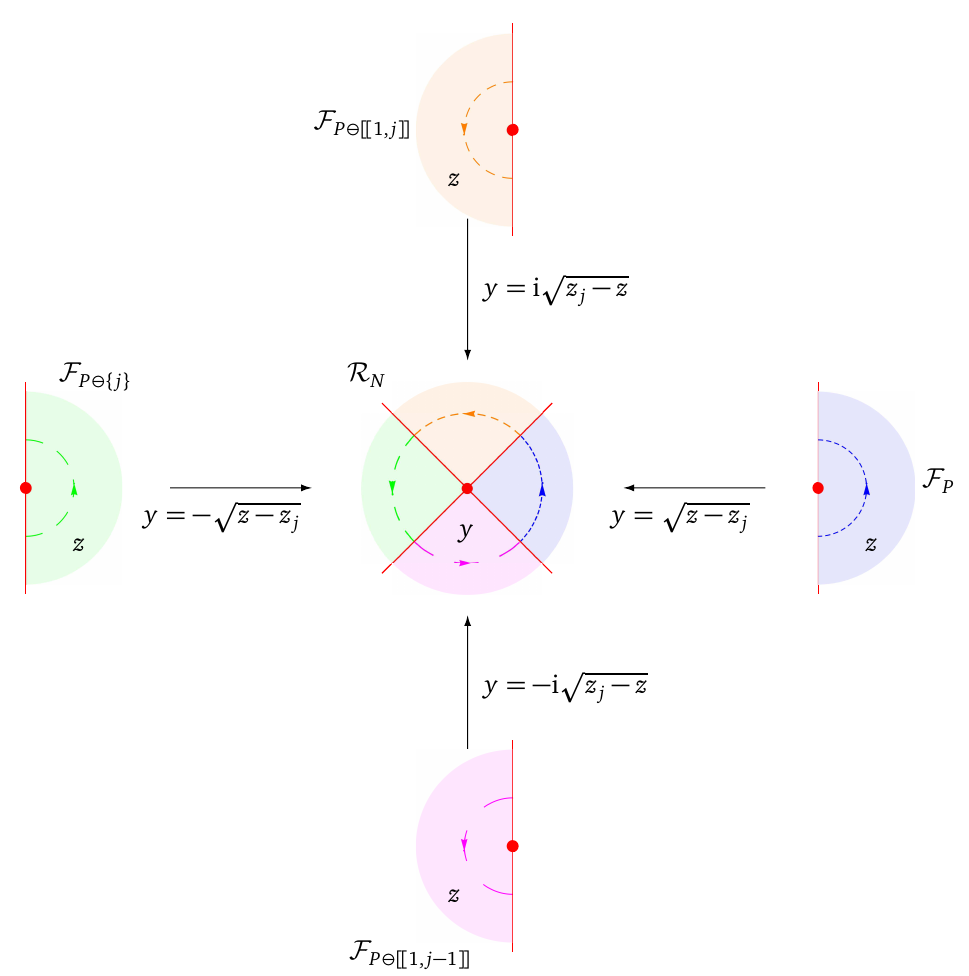
) ] = [( z ) ] = [( z ) ] , F , F , F j P j P (cid:9) [[ 1, j ]] j P (cid:9){ j } r l r , formed by gluing four quarter-disks N , F , F P P (cid:9) [[ 1, j ]] P (cid:9){ j }